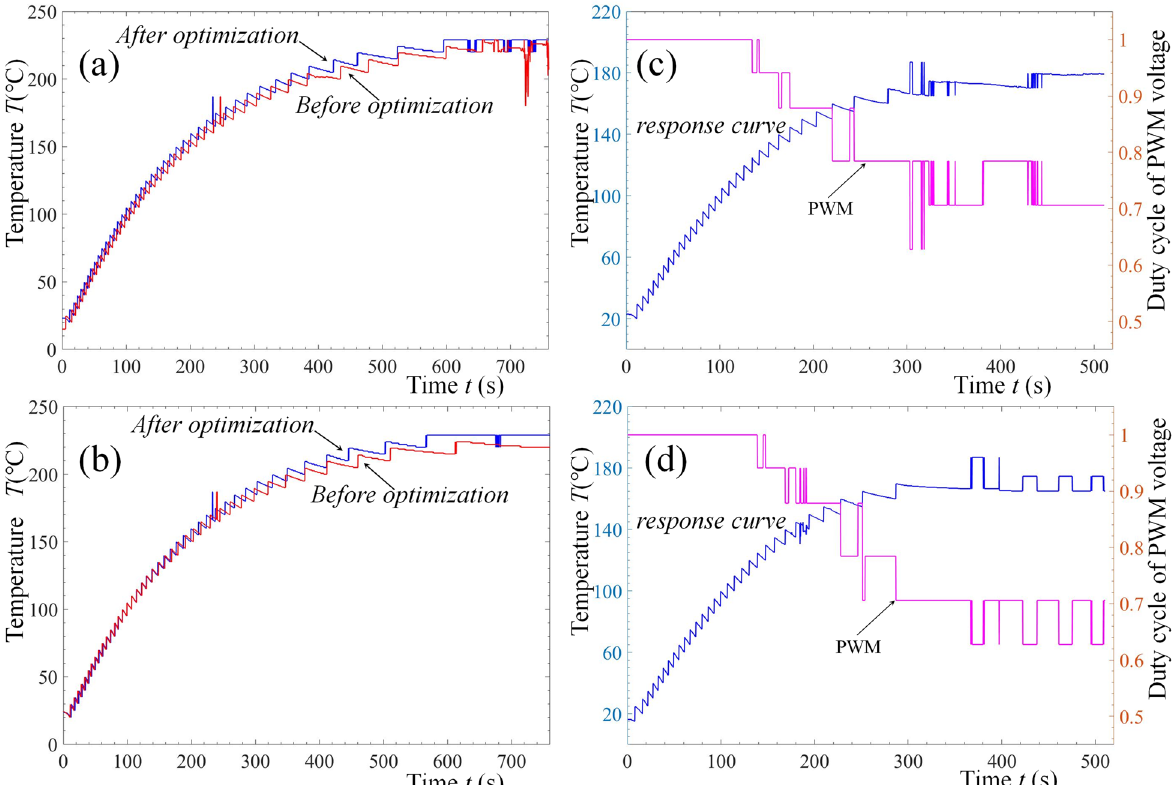
Fig. 5 Heating curve of GF PLA of two repeated tests ( a , b ) and ( c , d ), where the left column is response curve whereas the right is their real-time curve of PWM during thermal